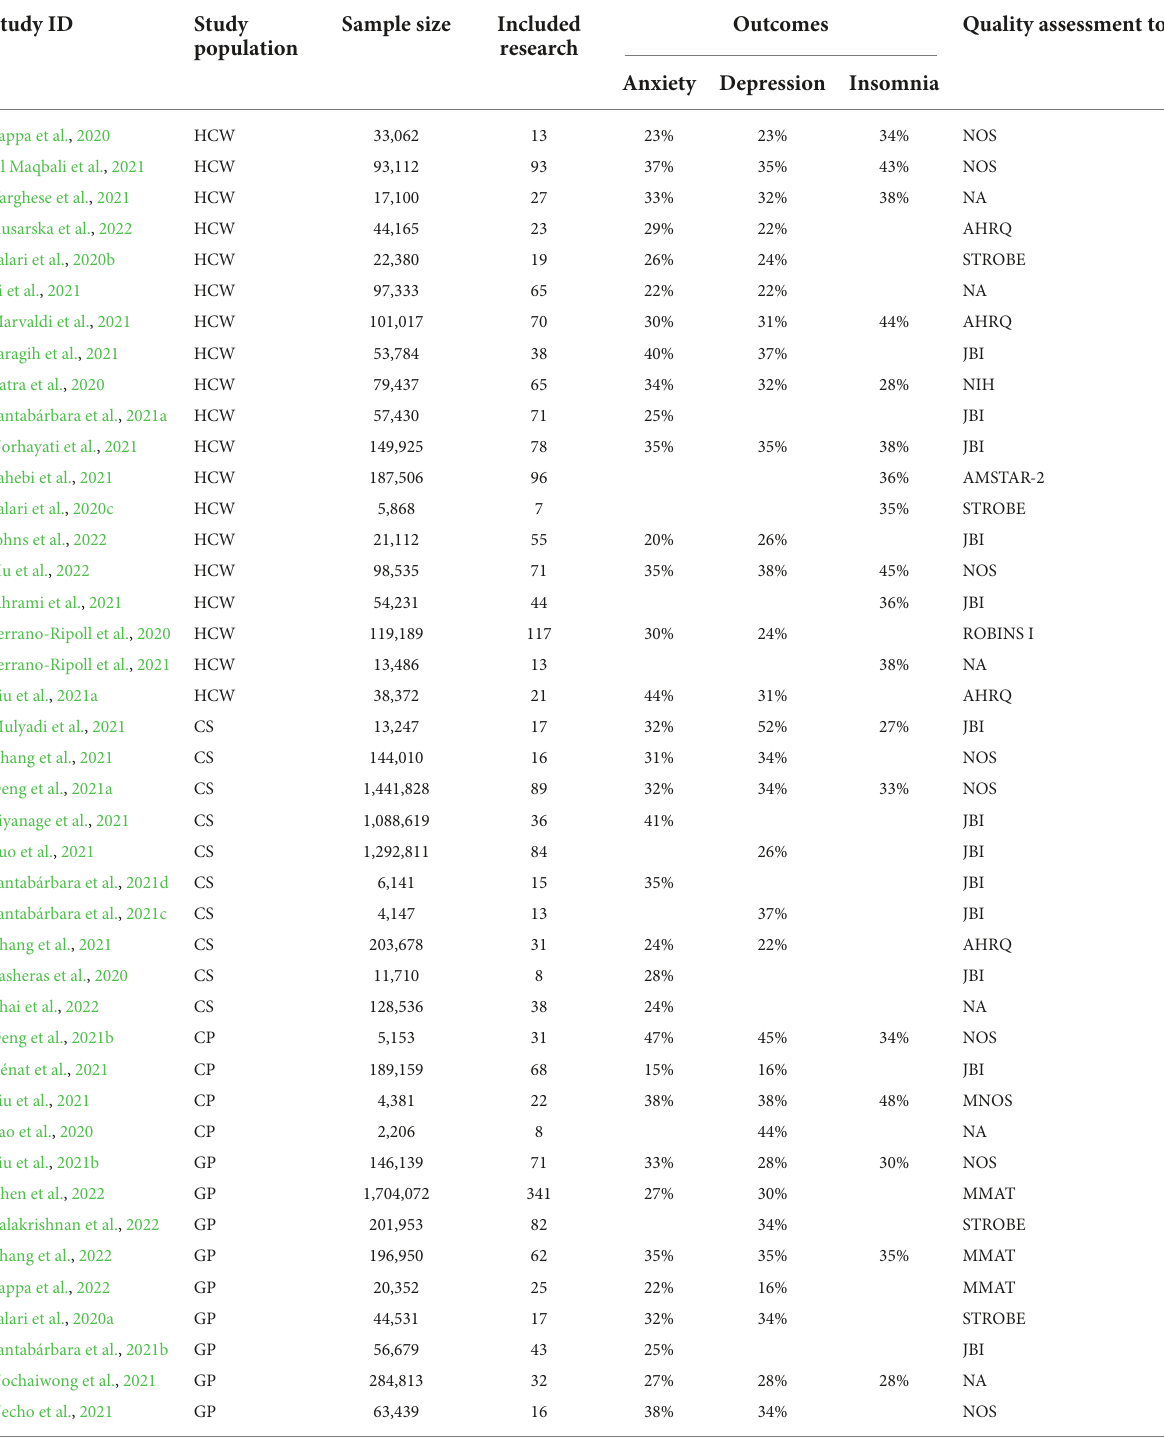
TABLE 1 Characteristics of included systematic reviews ( n =